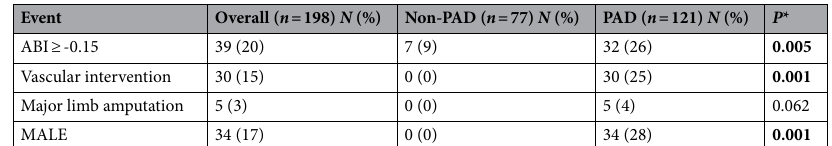
Table 2. Distribution of adverse events in PAD patients compared to non-PAD patients during 2-year follow-up. *The significance of the difference between non-PAD group and PAD group using chi-square test. All p -values were rounded to three decimal places, P < 0.05 in bold. ABI: Ankle Brachial Index; MALE— defined as vascular intervention or limb loss.